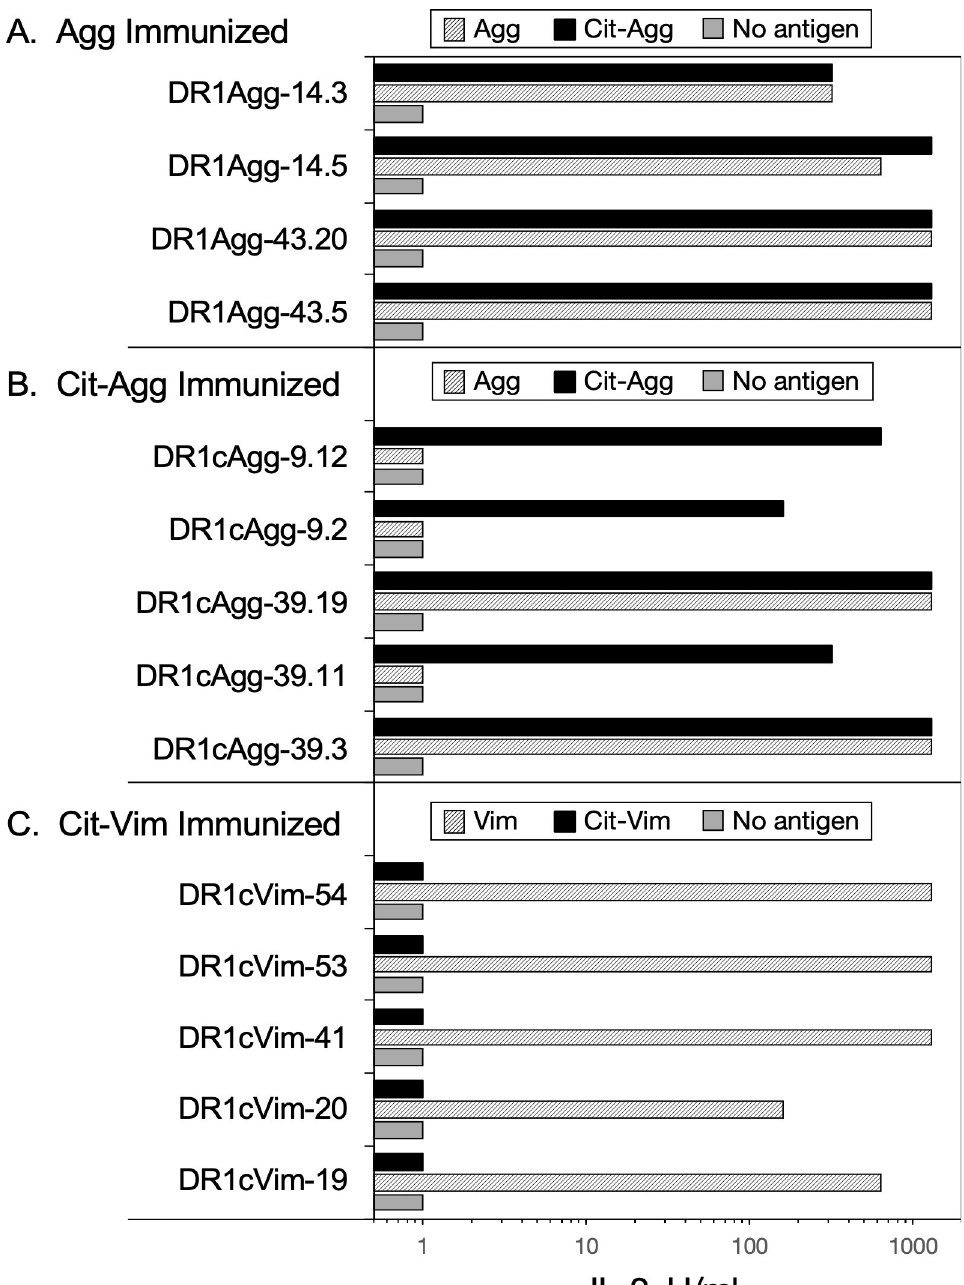
Fig 6. T cell receptor cross recognition of WT and Cit-peptides. Clonal populations of T cells were tested for their ability to recognize WT or Cit-peptides in antigen presentation assays as described in Materials and Methods. T cells from Agg, Cit-Agg, and Cit-Vim immunized mice were used to produce T-cell hybridomas, and multiple clones from each were tested for their ability to recognize the immunogen and the corresponding WT or Cit-peptide. Data indicate that cross recognition of WT and Cit-peptides can occur at the clonal level, and that Cit-peptides can be novel antigens for T cell responses. Data shown are representative responses from multiple clones tested from each immune T cell